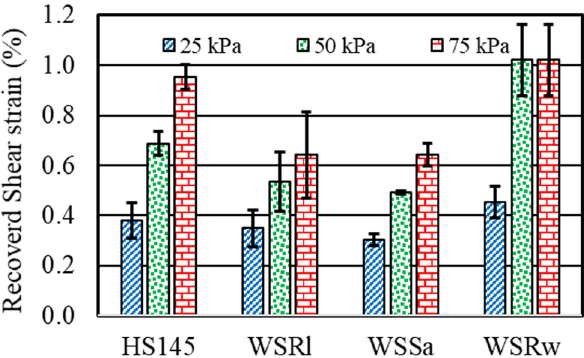
Figure 22: Final recovered shear strain at the termination of MSCR.